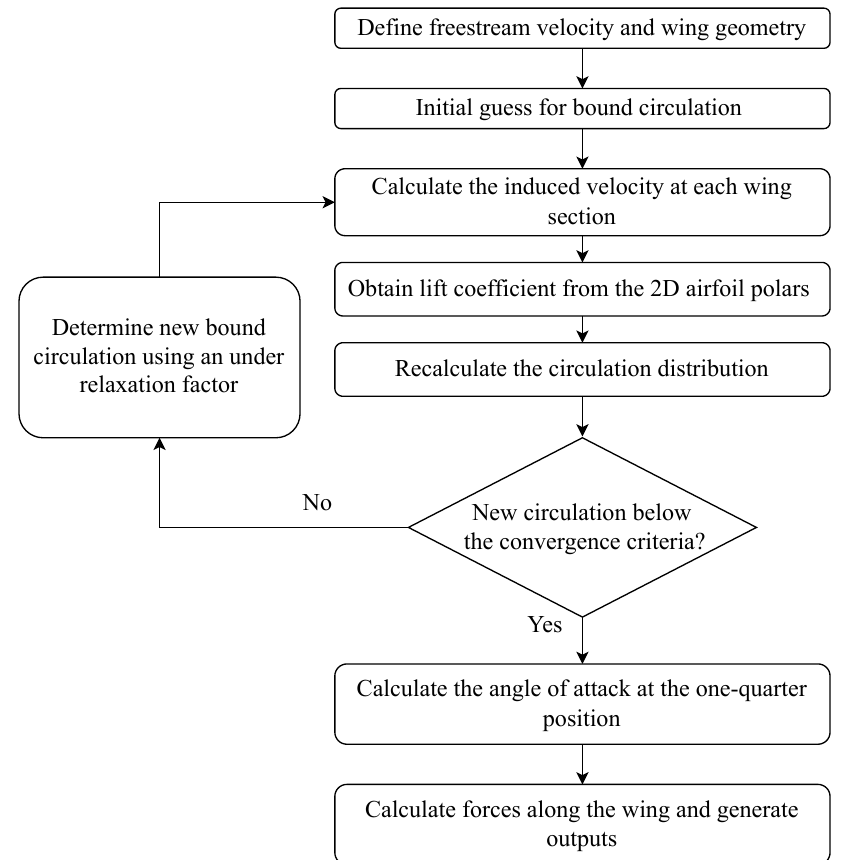
Figure 4. Flowchart of the vortex step method.